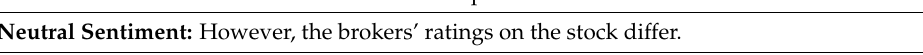
Table 1. Sentences of the Financial Phrase Bank [17]. Positive Sentiment: Sales have risen in other export